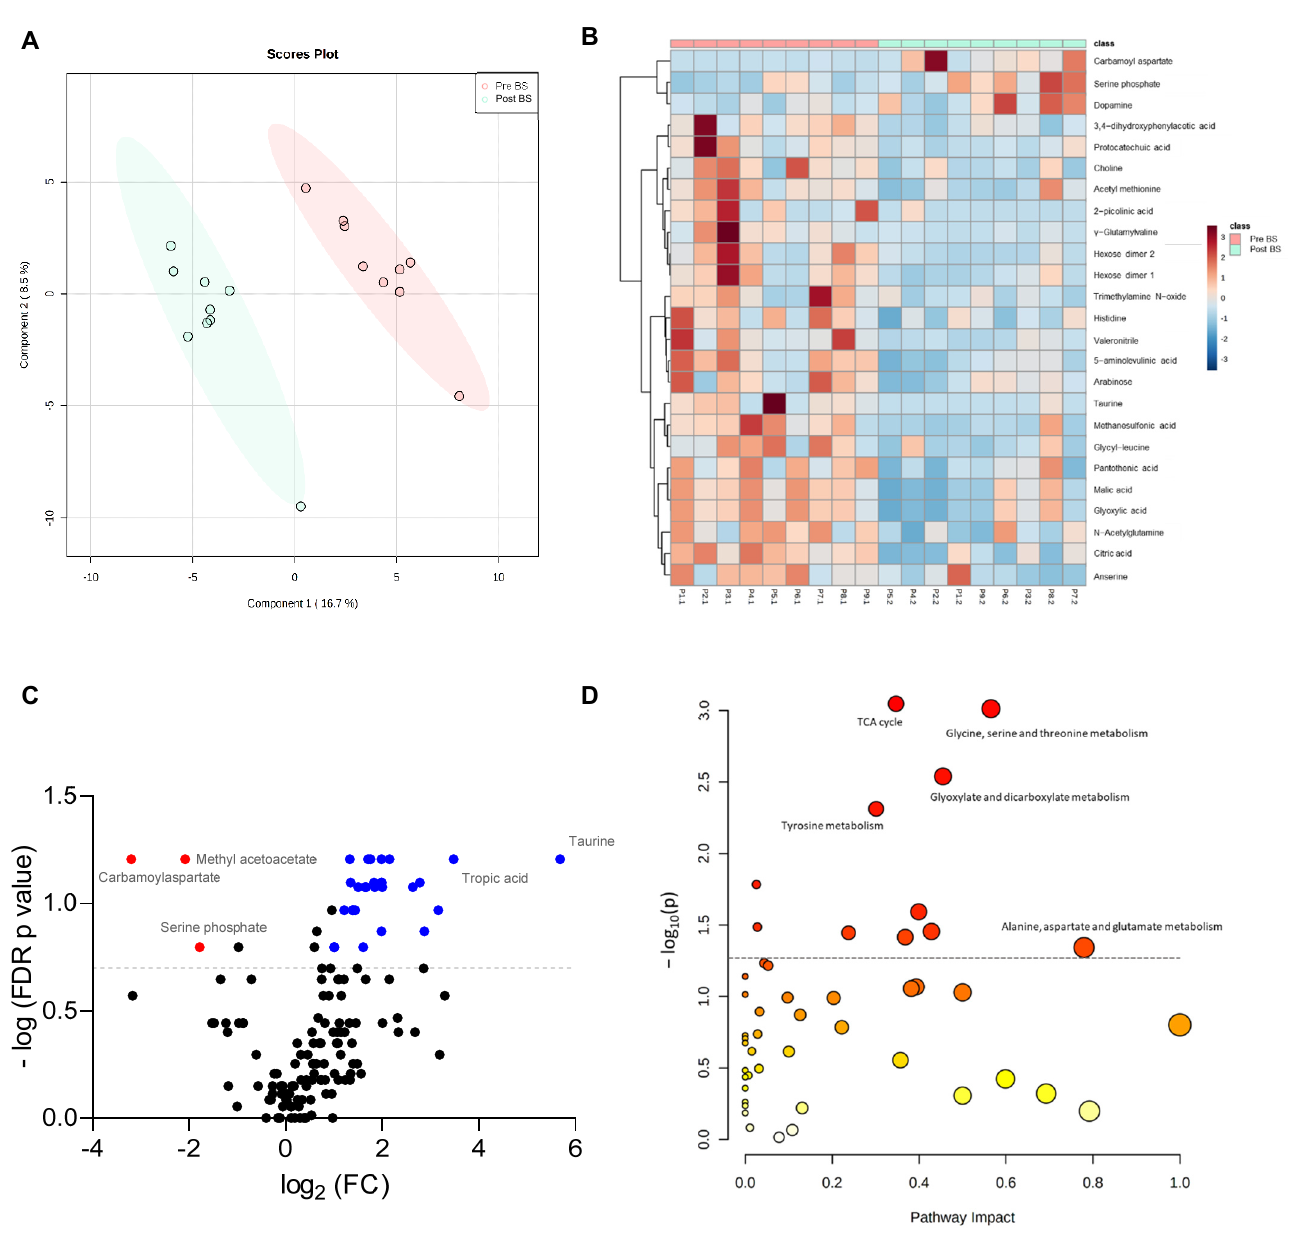
Figure 3. Effect of bariatric surgery on faecal metabolome of patients with severe obesity. ( A ) Partial Least-Squares Discriminant Analysis (PLS-DA) of faecal metabolites of patients with severe obesity before (Pre BS) and after (Post BS) bariatric surgery. ( B ) Heatmap showing normalized abundance of the top 25 discriminating faecal metabolites based on univariate t tests in the patients with severe obesity Pre BS and Post BS. Colour scale denotes higher (red) to lower (blue) abundance. Left side dendrogram represents correlations between metabolites based on Pearson’s correlation. ( C ) Volcano plot showing faecal metabolites with Wilcoxon signed-rank test p < 0.05 and fold-change (FC) >2 (positive FC in blue, negative FC change in red) due to bariatric surgery. ( D ) Pathway enrichment analysis showing the metabolic pathways significantly associated with surgery. The circle colour (from light yellow to red) is based on its p -value, and radius represents pathway impact value. Discontinue grey line denotes p value threshold of